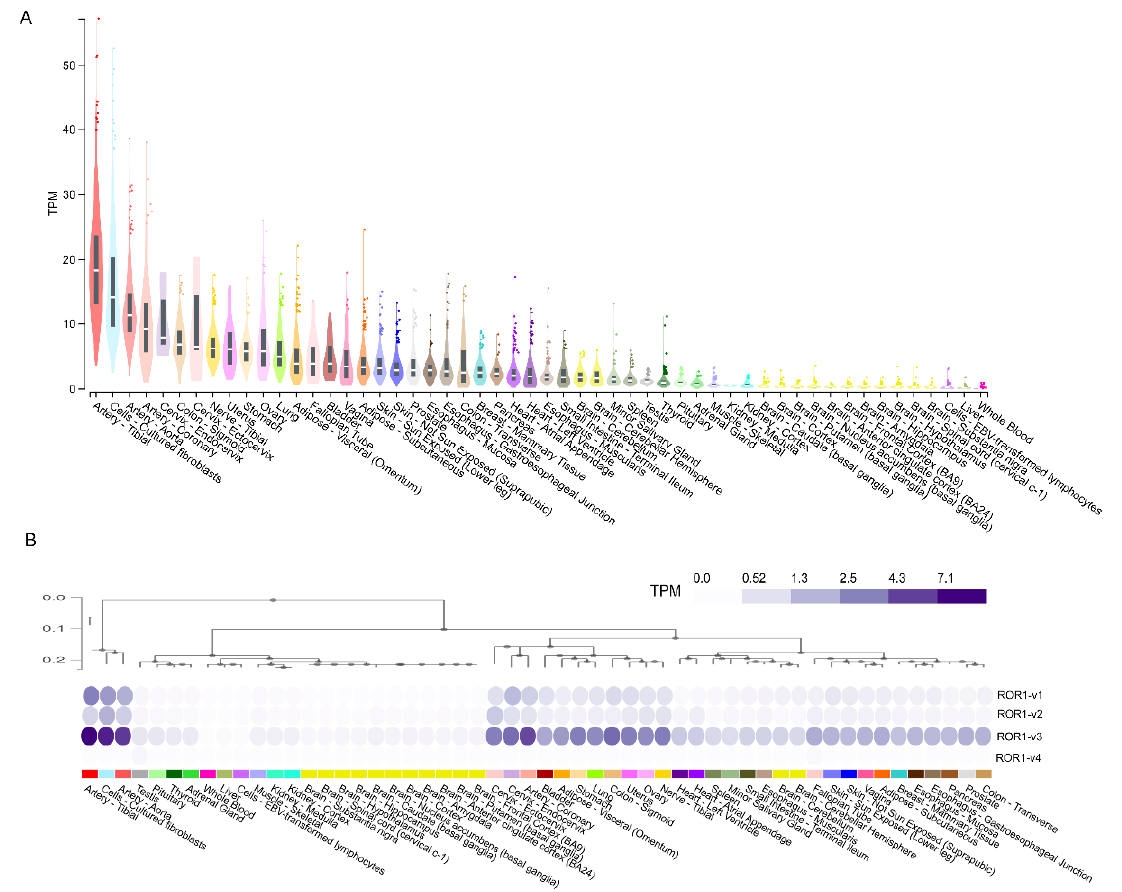
Figure 2. Analysis of ROR1 gene and transcript variant expression in the human body: Gene expression ( A ) and transcript variant expression ( B ) of ROR1 in 17,382 samples across 54 non-diseased human tissues from nearly 1000 individuals profiled by the GTEx